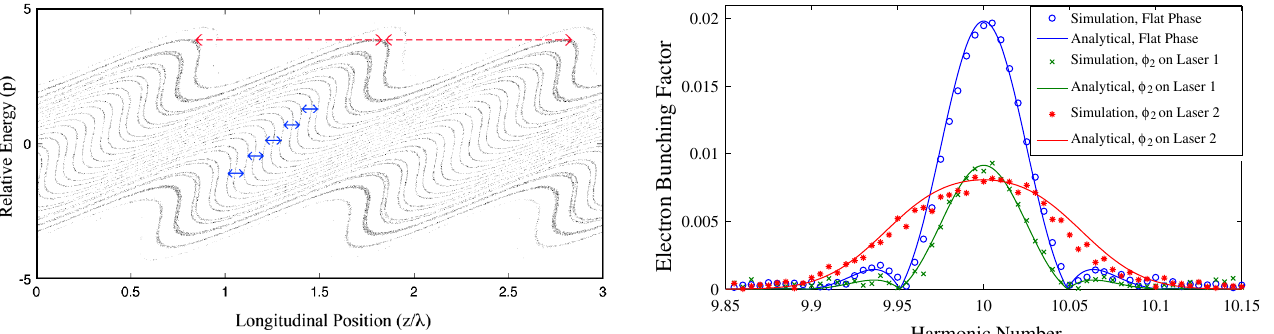
FIG. 10. Averaged bunching factor for 10th harmonic EEHG with Gaussian envelope for both laser stages. Quadratic phase (cid:5) 2 = 2 ¼ 1 ) reduces the bunching on the first seed laser ( (cid:3) k 2 factor, but does not broaden the bandwidth. The same quadratic phase on the second seed laser increases the bandwidth and TBP as found for HGHG. Solid lines show the numerical integral, Eq. (13).